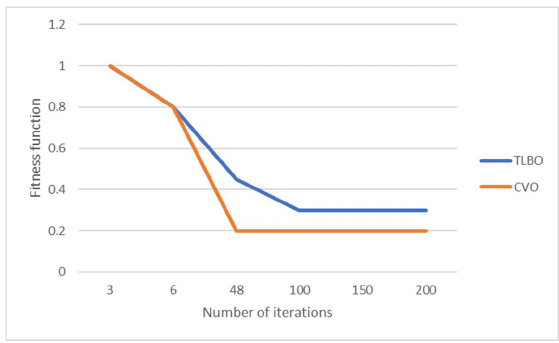
Figure 12. Convergence characteristics of TLBO and CVO.